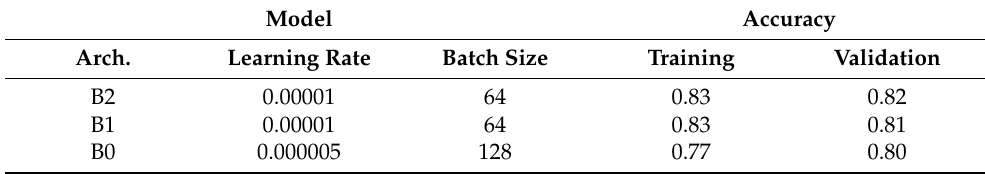
Figure 1. Training and validation accuracies of the model with the highest validation accuracy per EfficientNet. Table 3. Trained EfficientNet models with training and validation accuracies.